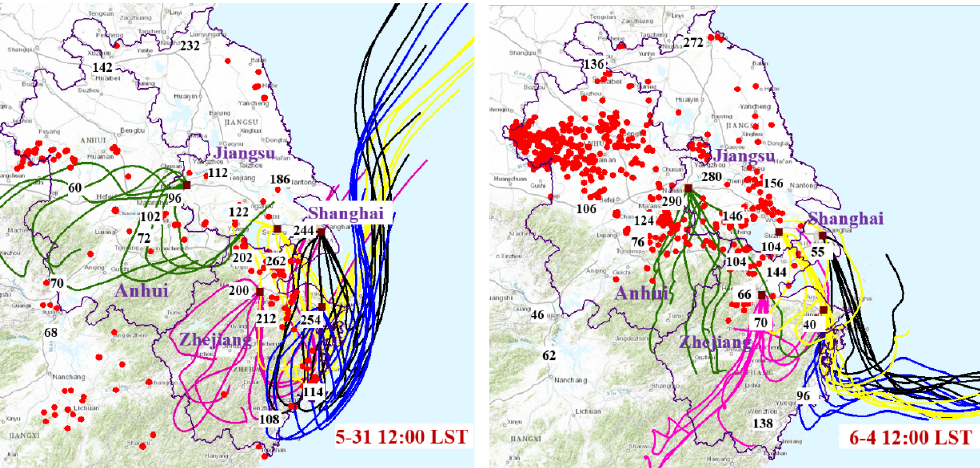
Fig. 7. HYSPLIT 24h back-trajectories at 100ma.g.l. originating at each monitoring site (black squares) calculated every 3h beginning at 12:00LST and ending at 09:00LST the previous day. Red dots represent the satellite-detected fires (FIRMS, Davies et al., 2009). Numbers are the daily average PM 10 mass concentrations from air quality monitoring (http://datacenter.mep.gov.cn/report/air_daily/air_dairy.jsp). Back-trajectory colors are Black – Shanghai, Blue – Ningbo, Pink – Hangzhou, Yellow – Suzhou, Green – Nanjing.